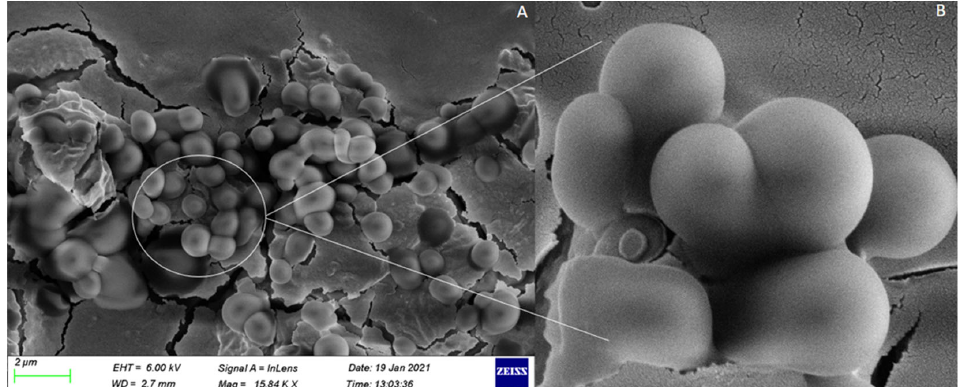
Figure 4. Gold ‐ platinum sputtered SEM micrograph of methotrexate ‐ loaded TPGS ‐ PLGA nanoparticles. ( A ) Magnification =15.84 KX; Voltage=6.00 kV ( B ) Magnification=44.34 KX; Voltage=6.00 kV. SEM of optimized methotrexate loaded nanoparticle formulation showing sphericity, smooth surface of nanoparticles.